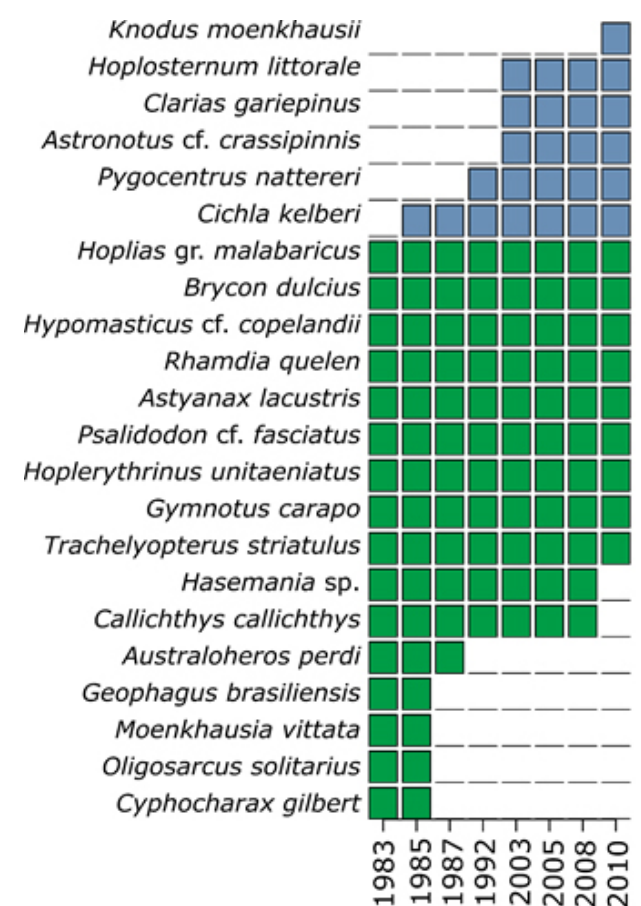
FIGURE 3 | Compositional change of the ichthyofauna from Carioca Lake, Middle Rio Doce basin state of Minas Gerais, southeastern Brazil. Green and blue squares indicate, respectively, the presence of native and introduced species in each